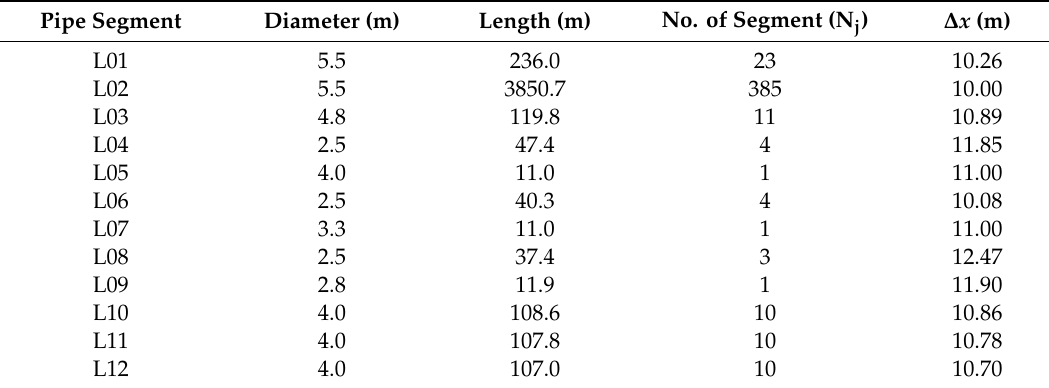
Table 1. Pipe segments and their calculation for ∆ t = 0.01